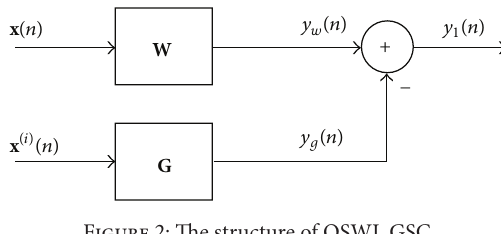
Figure 2: The structure of QSWL